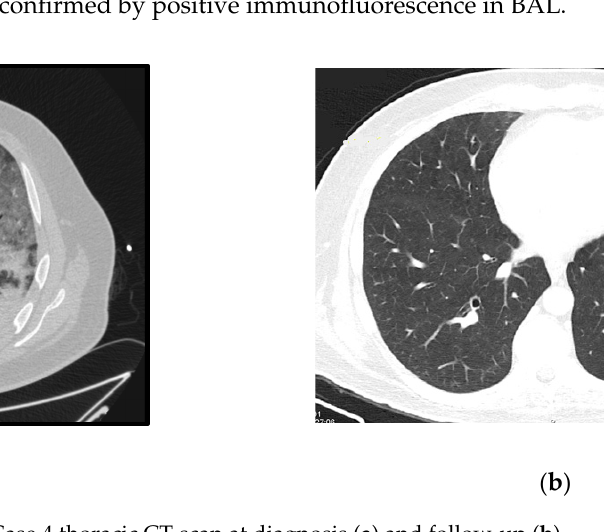
Figure 3. Case 3 thoracic CT-scan at diagnosis ( a ) and follow-up ( b ).